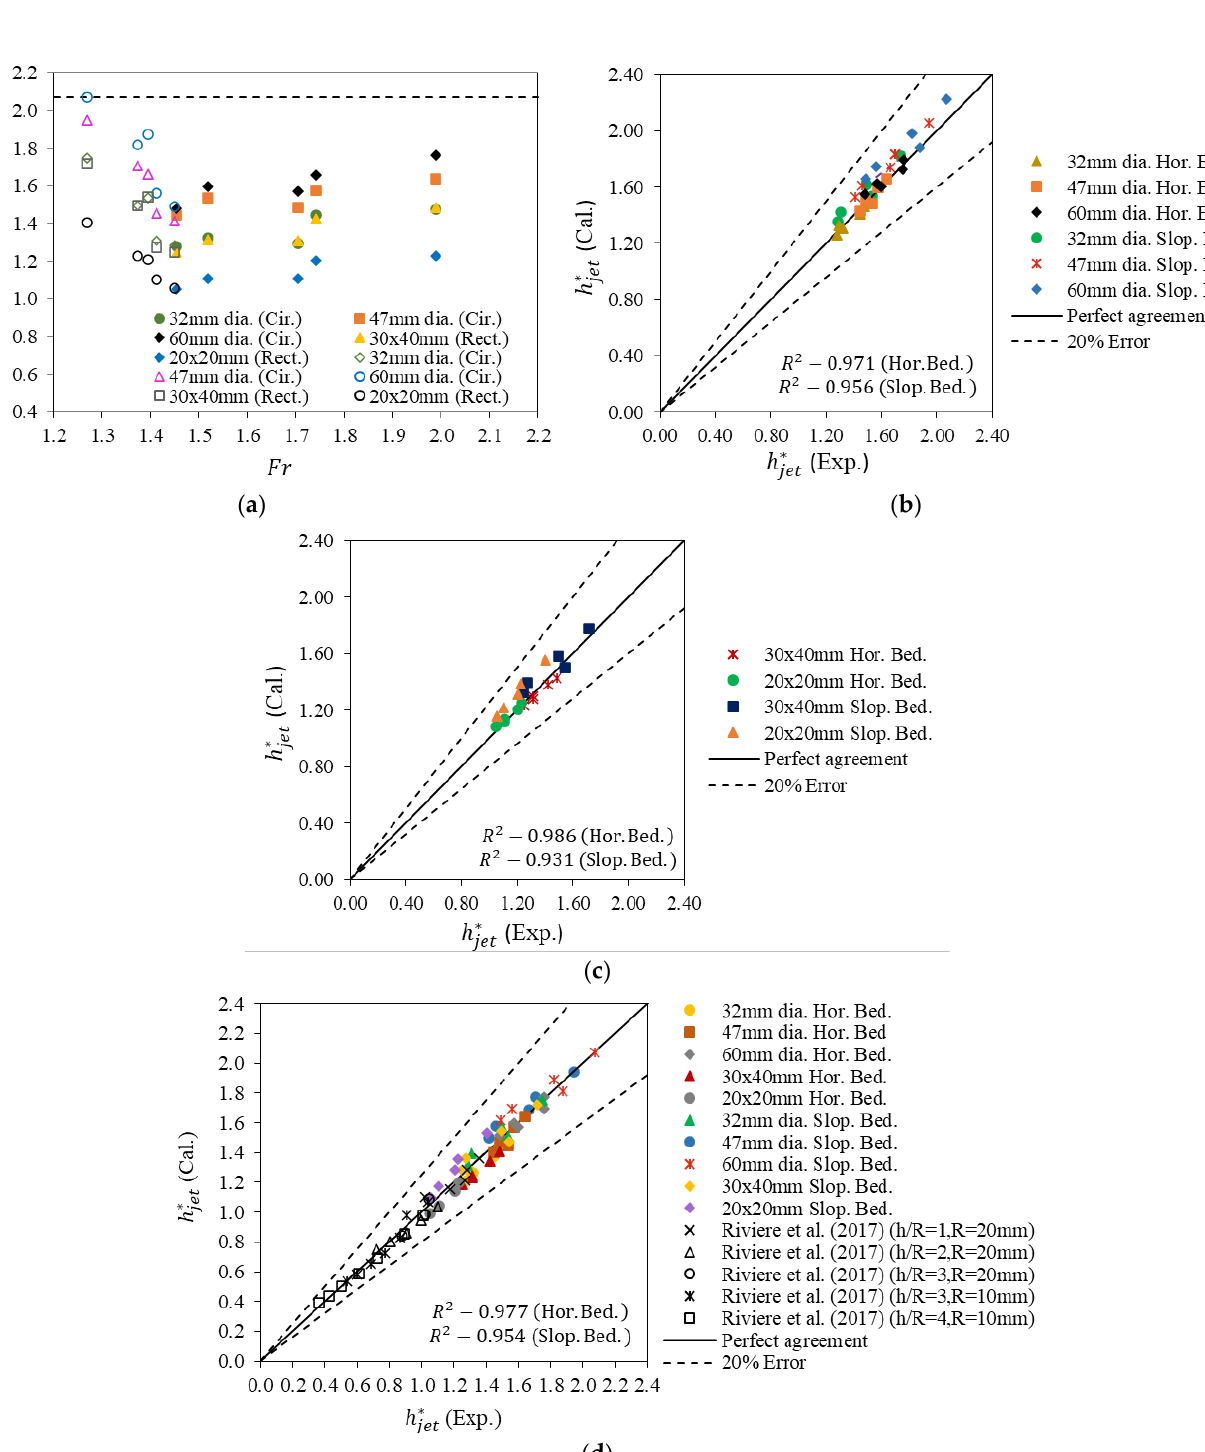
Figure 8. ( a ) Relative jet height in relation to time h ∗ the upstream Froude number for case C1, ( b ) correlation plot for the experimental dimensionless wall- jet height ( h ∗ ) and that predicted according to Equation (4) for the circular cylinders, ( c ) correlation jet plot for the experimental dimensionless wall-jet height ( h ∗ (4) for the rectangular cylinders, ( d ) correlation plot for the experimental dimensionless wall-jet height ( h ∗ ) and that predicted according to Equation (5) “Adapted with permission from Ref. [35]. jet 2017, Riviere et